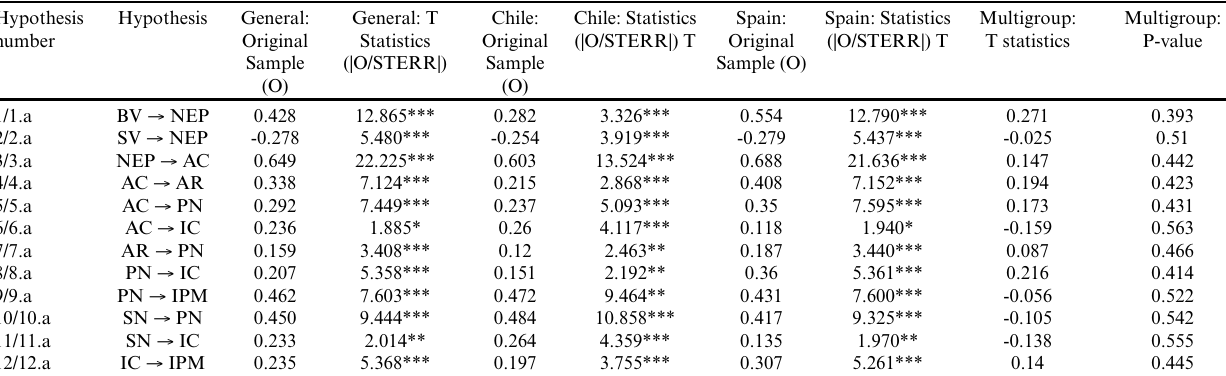
Table 5 . Summary of hypotheses tests by general model, country, and multigroup. Hypothesis